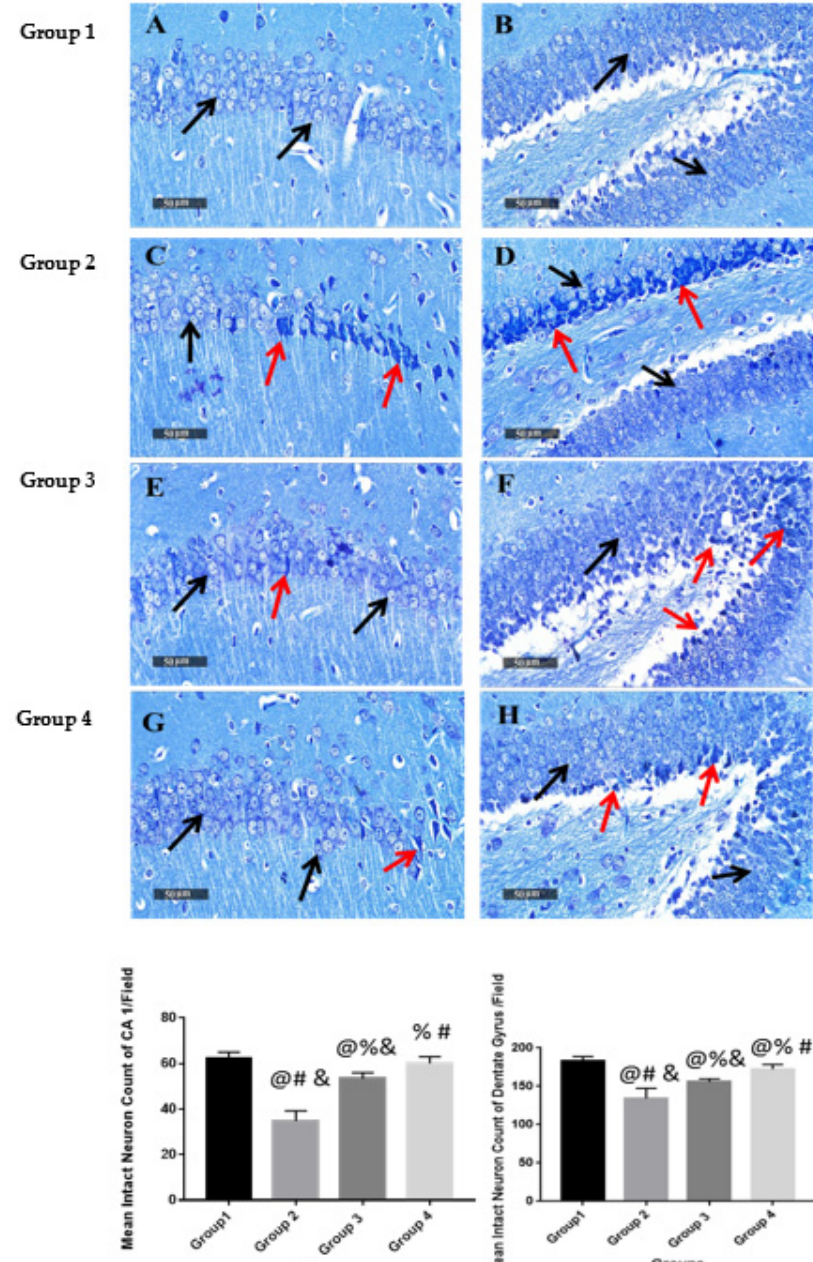
Figure 7. Light-microscopic examination of toluidine blue-stained pyramidal neurons in CA1 & Dentate Gyrus hippocampal sub regions in different groups with mean intact neuronal counts, 400X. Data were represented as mean ± SD ( n = 6), black arrows = intact neurons, red arrows = damaged neurons. ( A ) and ( B ) represent group1 (negative control). ( C ) and ( D ) represent group 2 (Positive control). ( E ) and ( F ) represent group 3 (ART). ( G ) and ( H ) represent group 4 (F3). Statistical analyses were performed using one-way analysis of variance (ANOVA) followed by Tukey’s post hoc test. @ Significant as compared to negative control (group 1). % Significant as compared to positive control group (group 2). # Significant as compared to ART (group 3). & Significant as compared to ART formulation (group 4). Significant difference was conducted by one-way ANOVA at p < 0.0001. In addition, the in vivo study also clarifies the critical role of using a suitable delivery system for phytoconstituents to better exert their pharmacological activity, increase their aqueous solubility and absorption, and decrease their systemic loss through